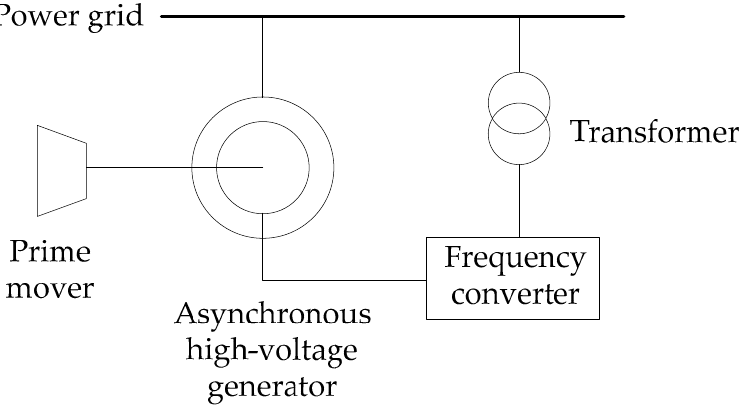
Figure 4. The system of the asynchronized high-voltage generator.